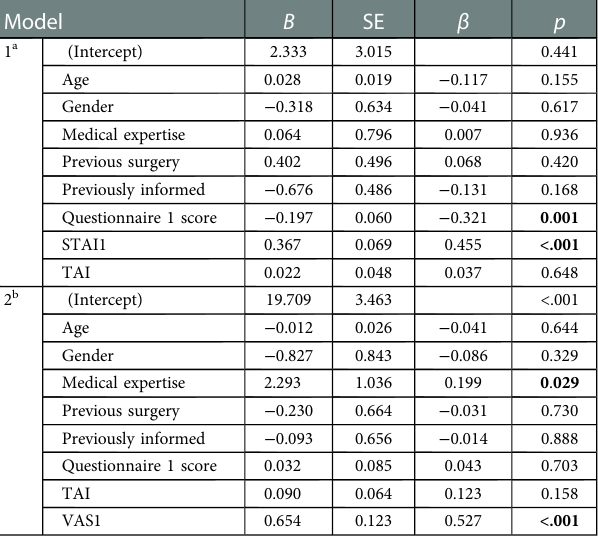
TABLE 2 Analysis of anxiety scores before the PE. Model